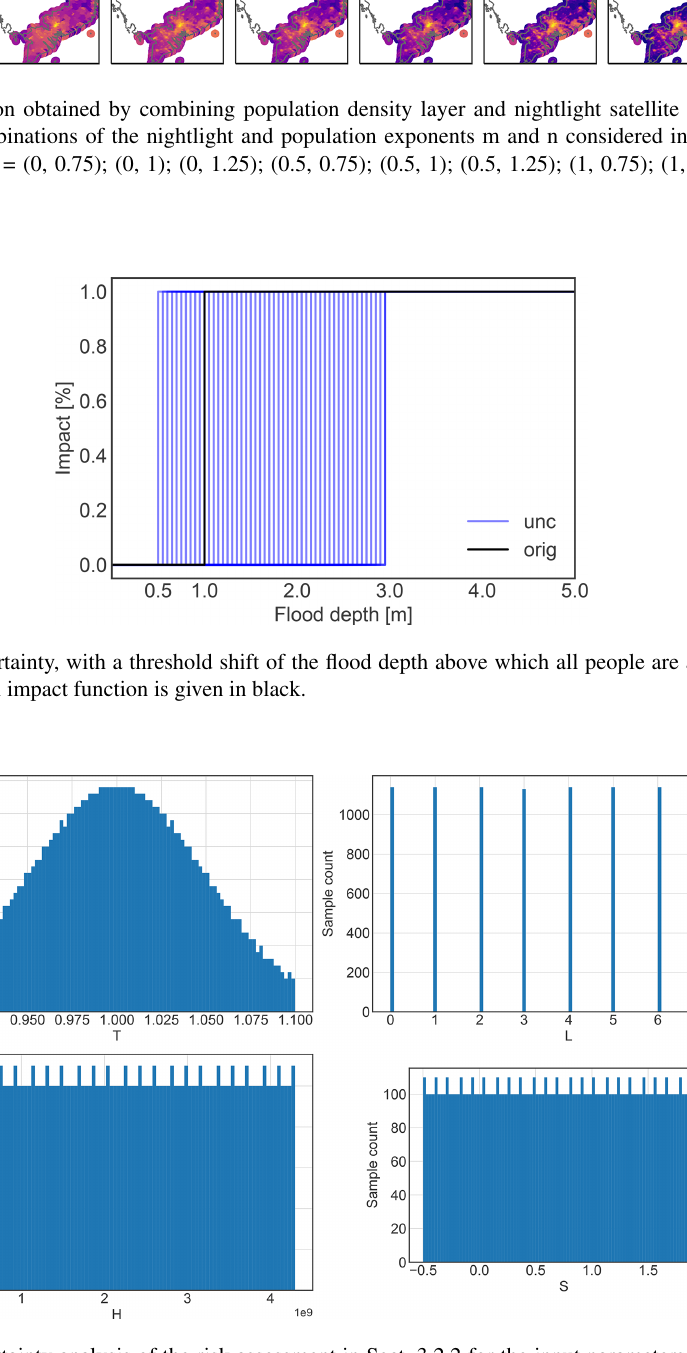
Figure D3. Samples for the uncertainty analysis of the risk assessment in Sect. 3.2.2 for the input parameters drawn from the distributions described in Table 1 using the sequence. The input parameters are T : total population, L : population L : population distribution, S : impact function threshold shift, and H : hazard events